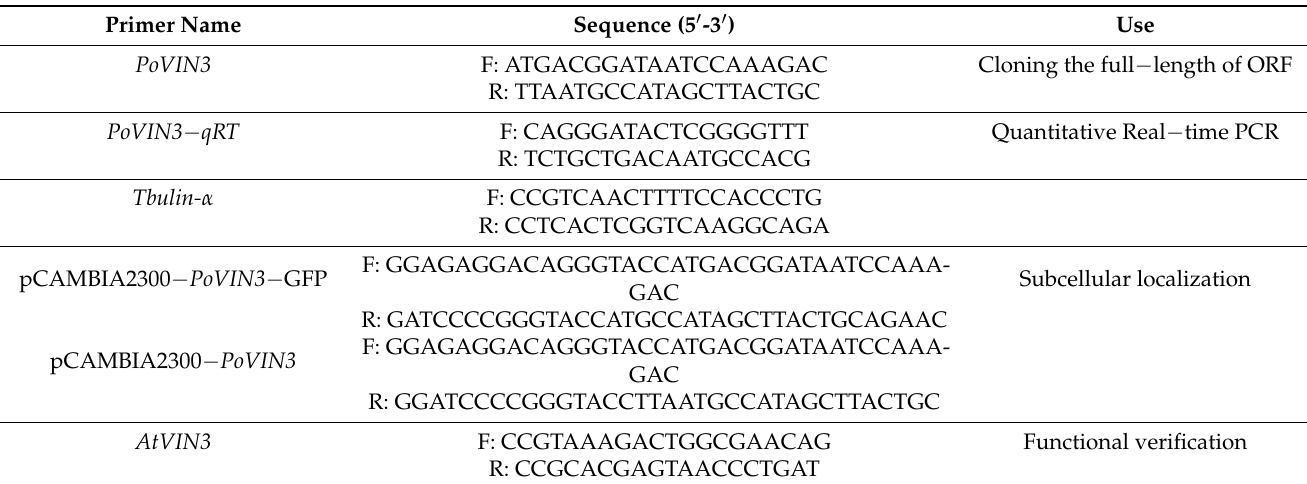
Table 1. Primer sequence in this